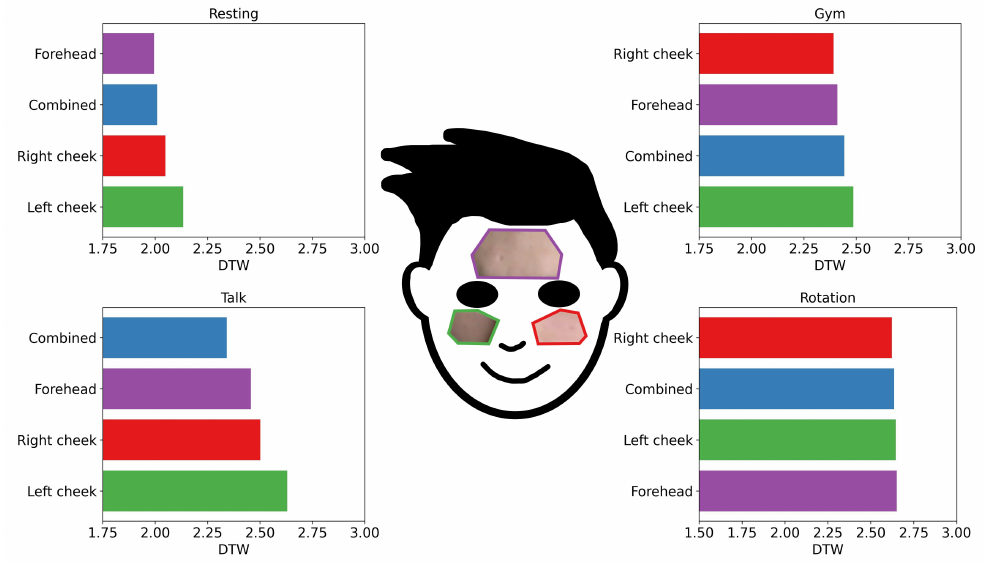
Figure 4. Comparison of DTW from the video activities Resting (top left), Gym (top right), Talking (bottom left), and Rotation (bottom right) for each ROI case. This chart shows the average of all the methods, participants, and windows for each investigated ROI. Note: DTW = dynamic time warping, ROI = region of